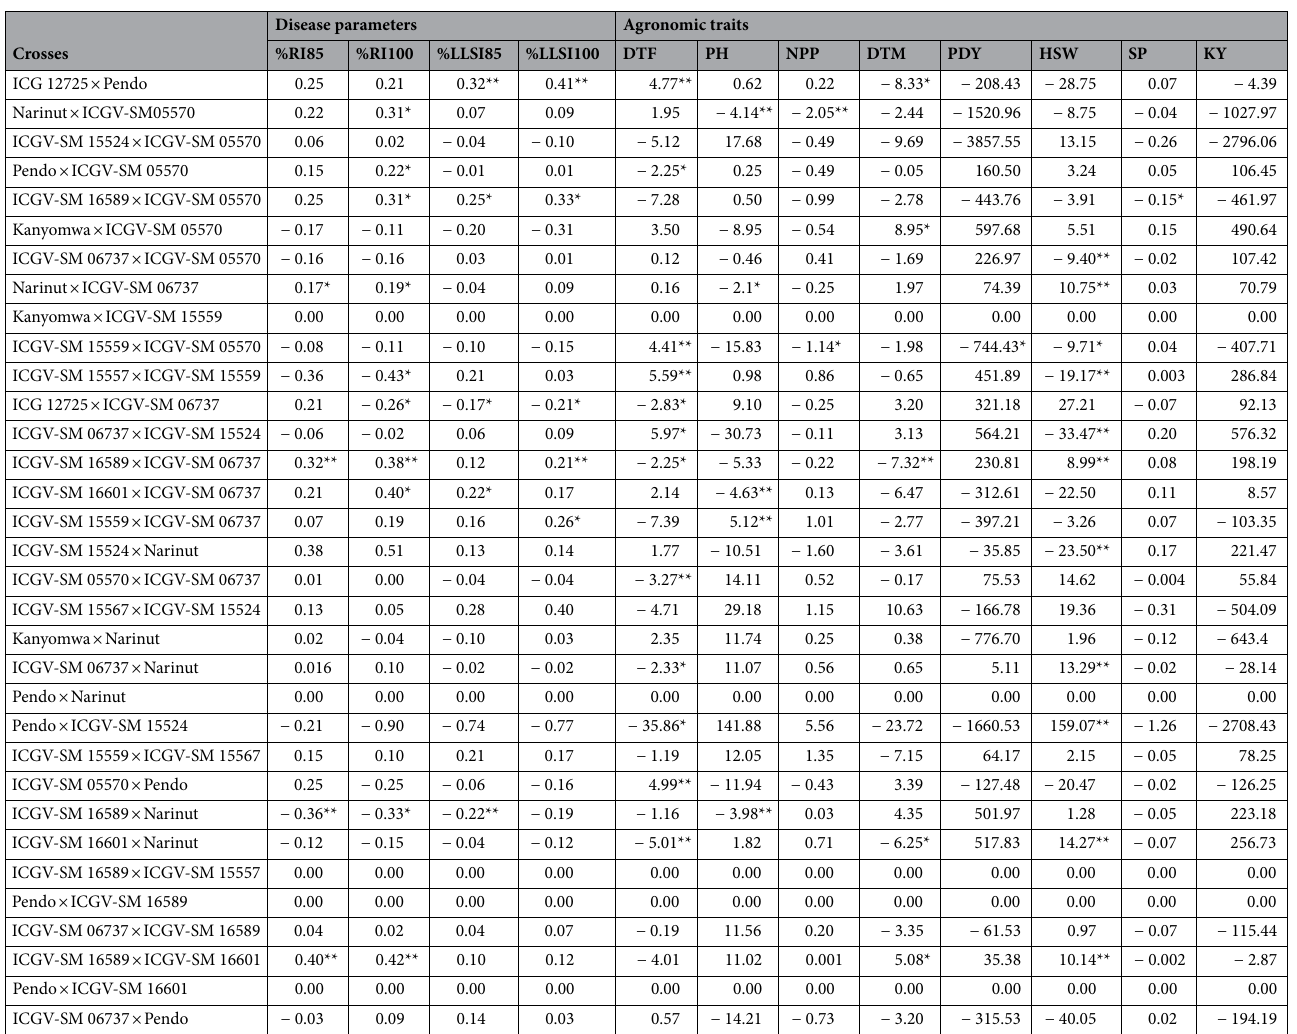
Table 8. Specific combining ability effects showing mean squares and significant tests for four disease parameters and eight agronomic traits of 33 F 2 families evaluated in two seasons in Tanzania. %RI85 percentage rust infection at 85 days after planting, %RI100 percentage rust score infection at 100 days after planting, %LLSI 85 Percentage late leaf spot infection at 85 days after planting, %LLSI 100 percentage late leaf spot infection at 100 days after planting, DTF days to flowering; PH plant height; NPP number of pods per plant, DTM days to maturity, PDY pod yield, HSW hundred seed weight, SP shelling percent, KY kernel yield. *,** and *** represent significant differences at 0.05, 0.01 and 0.001 probability levels,